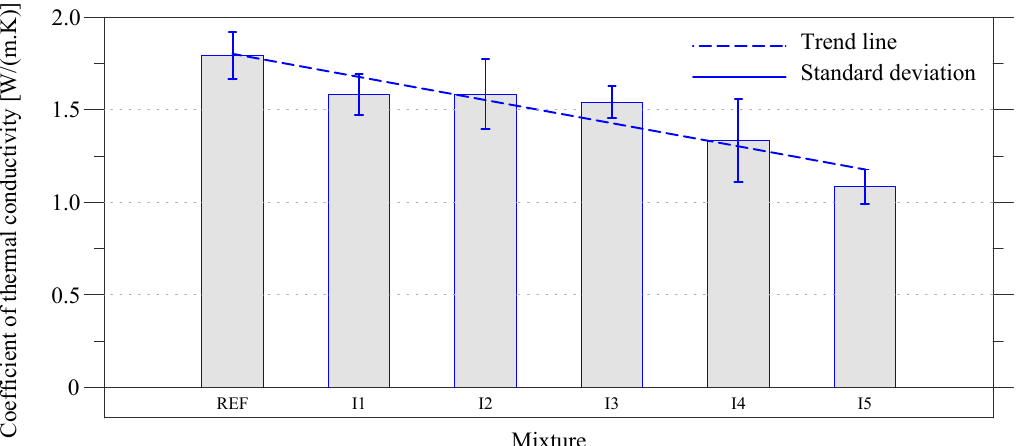
Figure 5. Thermal conductivity of tested